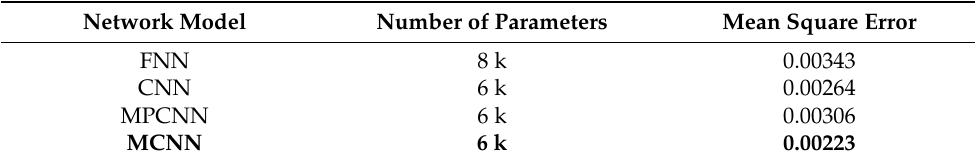
Table 6. Performance comparison of different